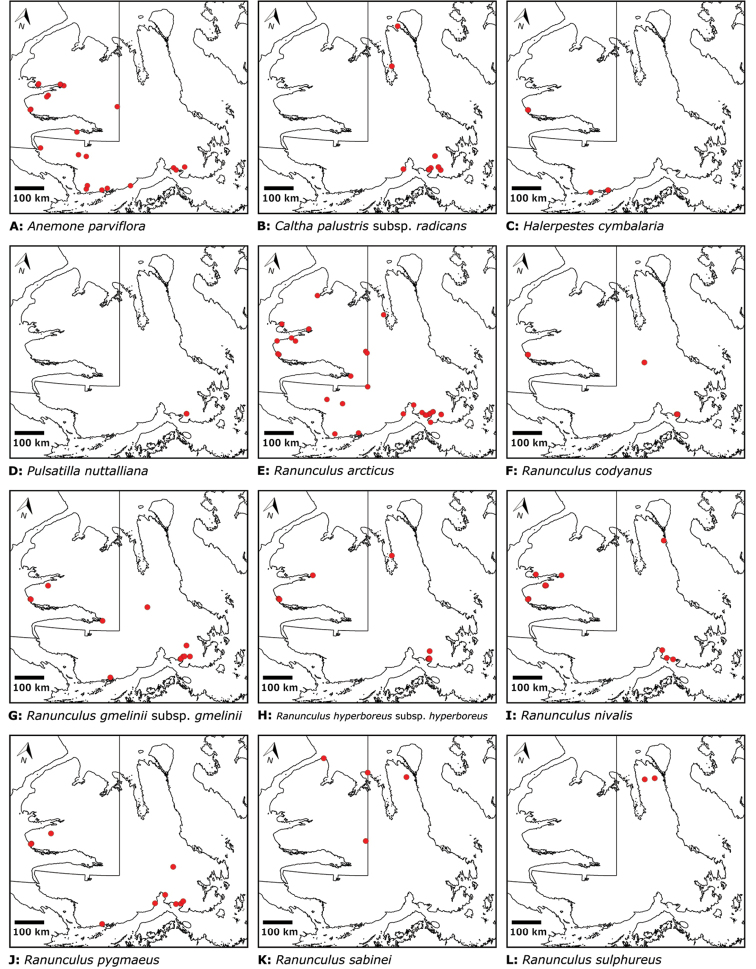
Species distribution maps. Ranunculaceae: AAnemone
parvifloraBCaltha
palustris
subsp.
radicansCHalerpestes
cymbalariaDPulsatilla
nuttallianaERanunculus
arcticusFRanunculus
codyanusGRanunculus
gmelinii
subsp.
gmeliniiHRanunculus
hyperboreus
subsp.
hyperboreusIRanunculus
nivalisJRanunculus
pygmaeusKRanunculus
sabineiLRanunculus
sulphureus.